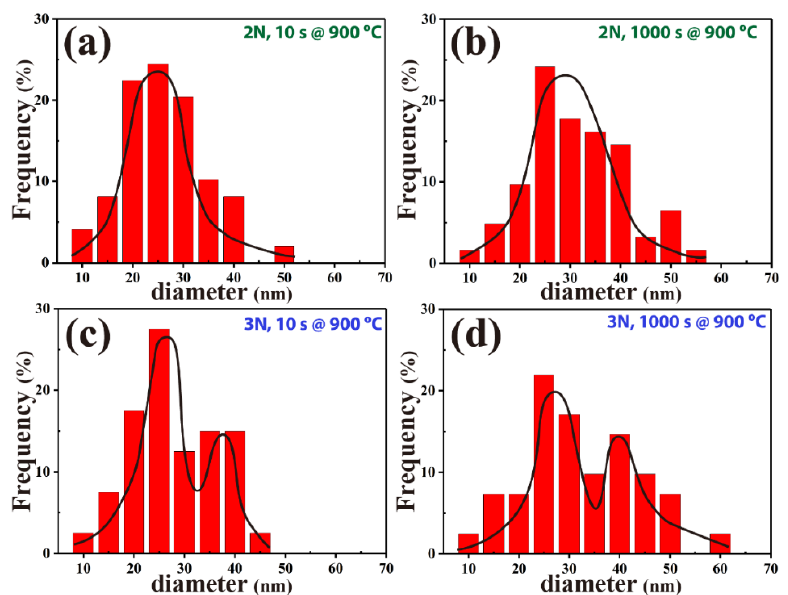
Figure 7. The size distributions of spherical NbC precipitates with peak curves: ( a ) Steel 2N treated at 900 ◦ C for 10 s; ( b ) Steel 2N treated at 900 ◦ C for 1000 s; ( c ) Steel 3N treated at 900 ◦ C for 10 s; ( d ) Steel 3N treated at 900 ◦ C for 1000